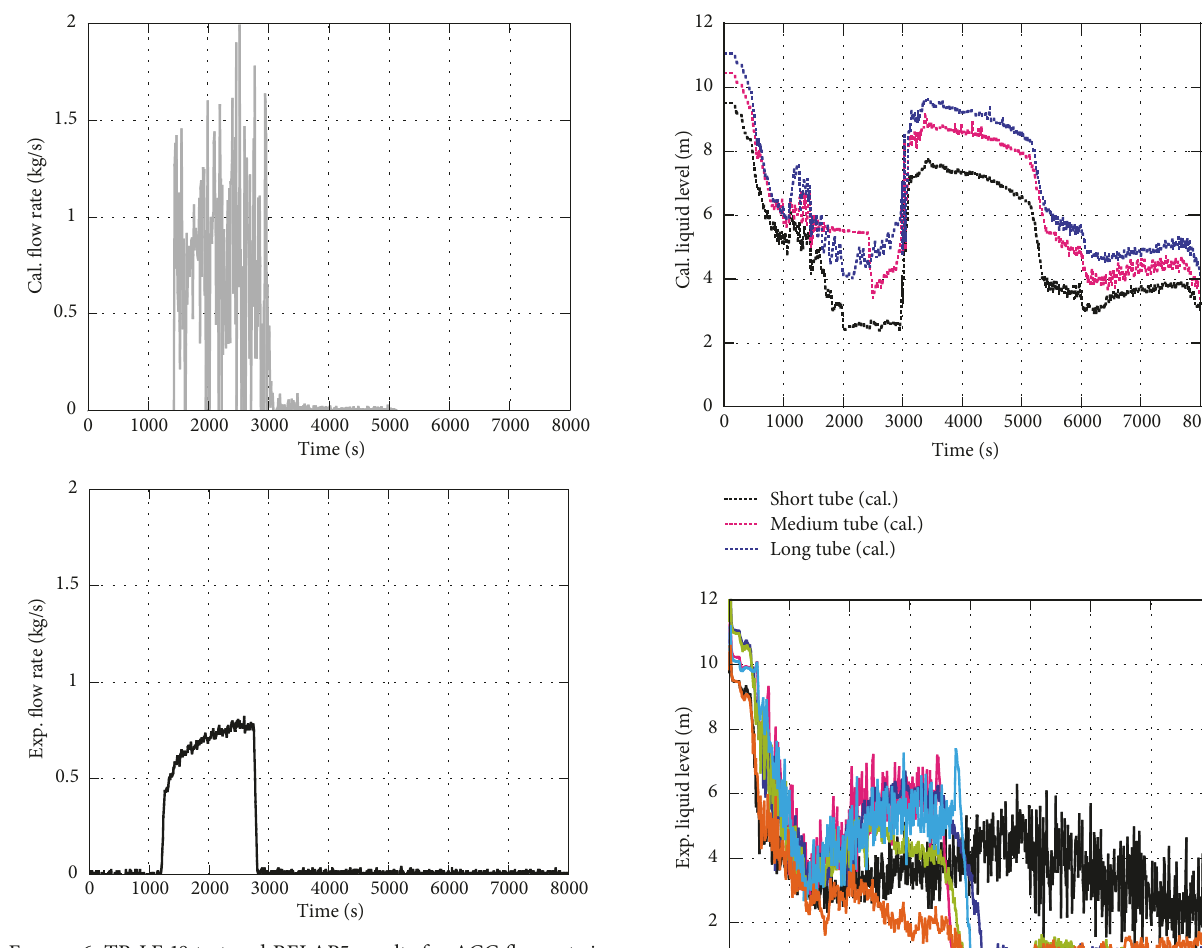
Figure 6: TR-LF-18 test and RELAP5 results for ACC flow rate in loop A.